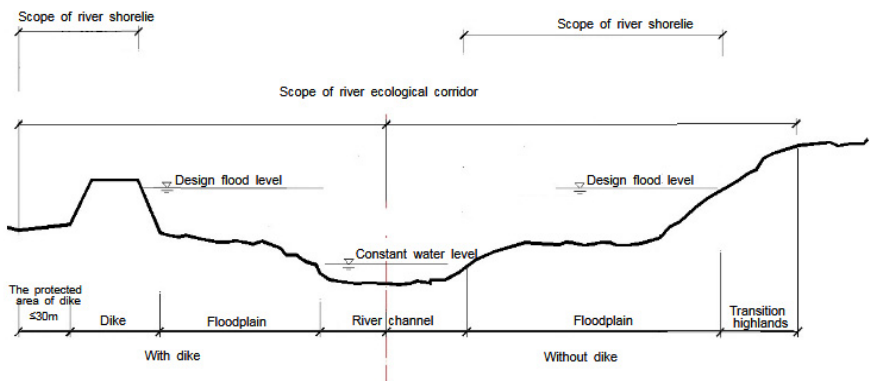
Figure 7. Schematic diagram of the river ecological corridor scope based on river shoreline. The scope of the shoreline is divided into two situations: with embankment section and without embankment section. Different situations lead to different ranges of the river ecological corridor. In the embankment section, the scope of the river ecological corridor is defined by the scope of the protected area of the dike. There is no dike section, its range is determined by the outer edge line of the transition zone at the edge of the highland.